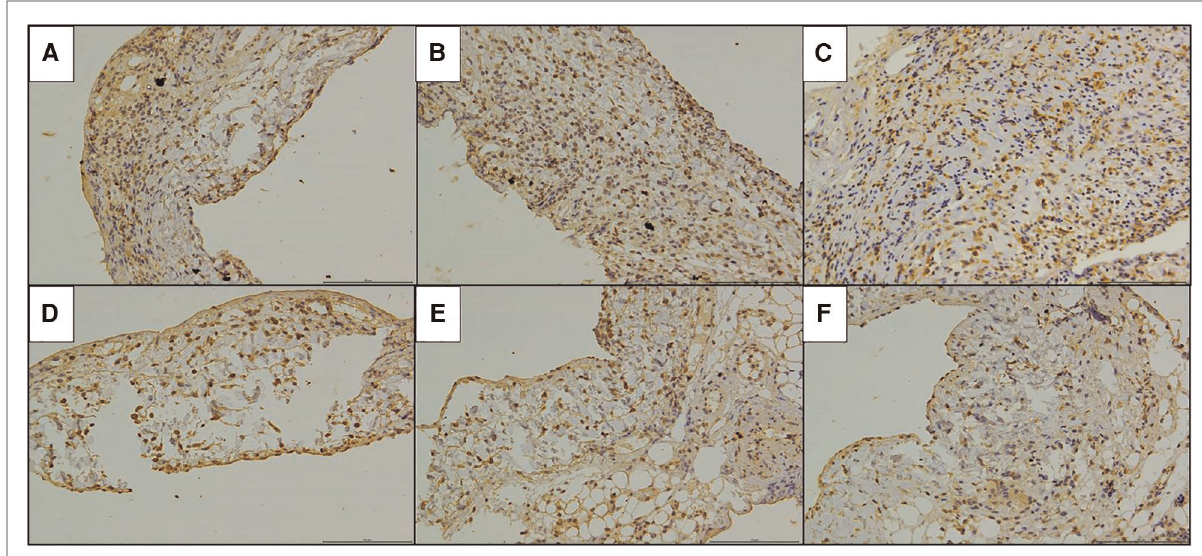
FIGURE 7 Immunohistochemical staining of CD8 in the replaced vessels after operation in two models of vein replacement (X200). ( A ) At 1 week after operation in the cuff group, patchy yellowish CD8+ lymphocytes were observed on the wall, especially in the adventitial layer. ( B ) At 2 weeks after operation in the cuff group, yellowish CD8+ lymphocytes were observed on the whole layer of the wall. ( C ) At 4 weeks after operation in the cuff group, yellowish CD8+ lymphocytes were observed on the every layer of the vessel wall, with no signi fi cant change compared with before. ( D ) At 1 week after operation in the suture group, scattered yellowish CD8+ lymphocytes were observed on the every layer of the vessel wall. ( E ) At 2 weeks after operation in the suture group, yellowish CD8+ lymphocyte in fi ltration was observed on the every layer of the vessel wall, with no signi fi cant change compared with before. ( F ) At 4 weeks after operation in the suture group, yellowish CD8+ lymphocytes were mainly concentrated in the adventitial layer of the wall.